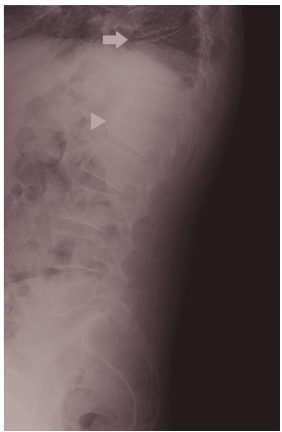
Figure 1: Plain radiograph of the lumbar spine revealed severe osteoarthritic changes of the thoracic and lumbar spine. There were compression collapse of T10/T11 vertebrae with mild retrolisthesis (white arrow) and a grade-one-to-two compression collapse of L1 vertebra with minimal retrolisthesis (white arrowhead).